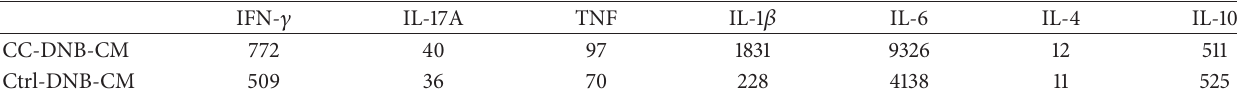
Figure 3: Proliferation of anti-CD3 plus anti-CD28 stimulated CD4 + peripheral blood T cells ( 𝑛 = 5 ) cultured in the absence or presence of two concentrations of conditioned medium (CM) derived from denuded biopsies (DNB) or from lamina propria mononuclear cells (LPMC) frominflamedCCmucosaornoninflamedcontrols,asanalysedonday3ofculture.Dataarepresentedaspercentageinhibitionofproliferation compared to cells cultured in the absence of CM. Each symbol represents data from one blood donor and the data points from CC and noninflamed controls for each donor are connected with a line. For LPMC fraction, CD4 + peripheral blood T cells from four blood donors were tested for proliferation analysis. Table 1: Protein levels (pg/mL) of cytokines analysed in pooled condition medium (CM) derived from denuded biopsies (DNB) from inflamed collagenous colitis (CC) mucosa or normal mucosa (control, 𝑛 = 20; CC, 𝑛 =